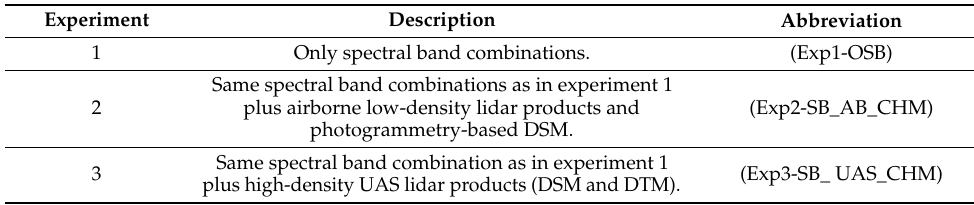
Table 7. Spectral band combinations studied. Spectral Band Combinations for Exp1-OSB Composite of all the bands acquired by the multispectral sensor as follows: blue, B_G_R_RE_NIR green, red, red edge, and near infrared. Micasense MX RedEdge-MX (AgEagle Sensor Systems Inc., 2022) and Sentera’s 6X (SENTERA, 2022) multispectral sensors. Composite containing the visible blue, green, and red, bands traditionally captured B_G_R by most low-cost consumer cameras. Emulates the use of built-in generic photographic UAV-mounted cameras. G_R_RE Emulates the use of relatively inexpensive cameras (compared to full multispectral G_R_NIR sensors) on the market, designed for specialized purposes with specific band B_G_R_NIR combinations, built to meet customers B_G_R_RE